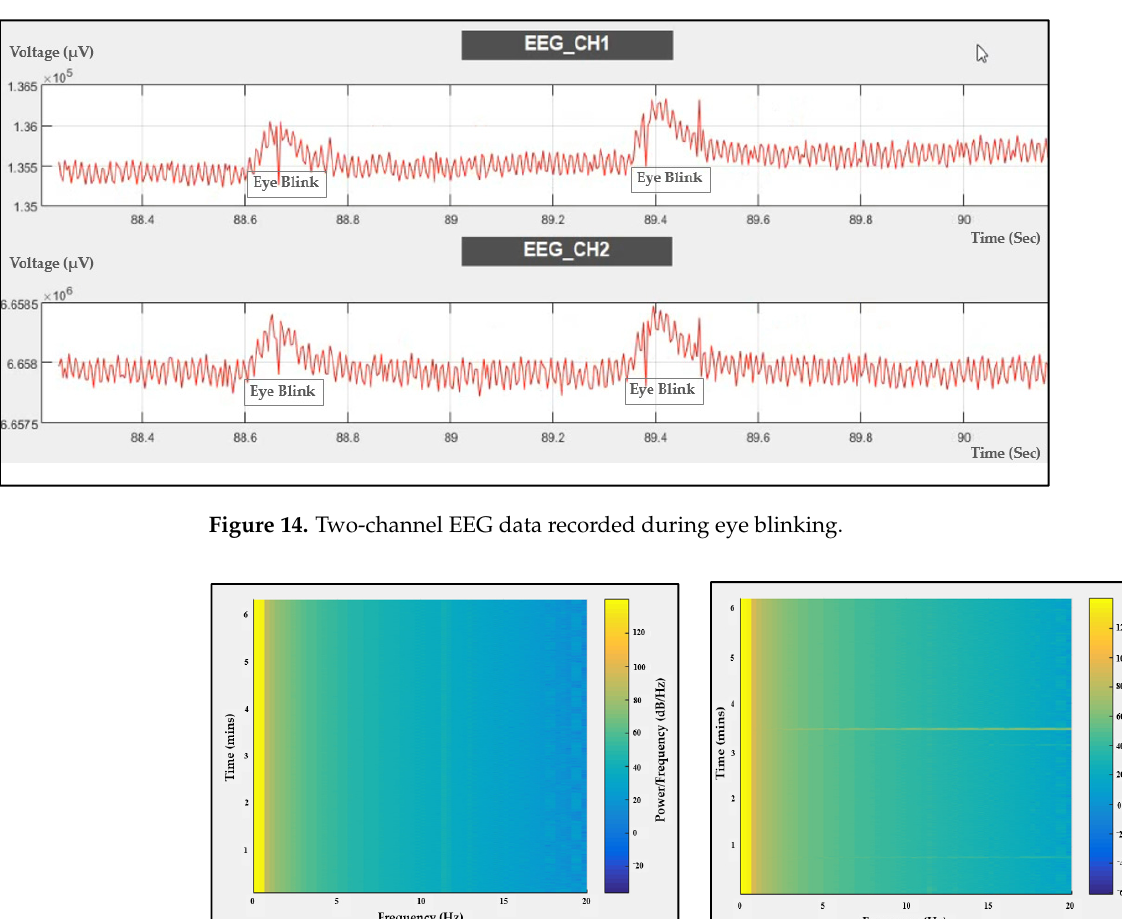
( b ) Figure 15. Alpha wave detection while (a) eyes were open and (b) eyes were closed. 4.3. FNIRS Signal Using EEG/fNIRS System 4.3.1. fNIRS Recording Using Solid Phantoms fNIRS signal was evaluated using two silicon-based tissue phantoms made from pol- ydimethylsiloxane (PDMS), curing agent, TiO2, and India ink. In the near-infrared range, PDMS has a refractive index of about 1.43 (equal to tissue refractive index). TiO2 is con- sidered as a scattering agent for setting the scattering properties of the phantom, and the India ink set the absorption properties of the phantom. The amount of India ink used in one phantom was more than that used in the other (darker phantom contains 220 g of silicon, 24.8 g of curing agent, 0.317 g of TiO2, and 270 µL of India ink) to represent a high absorbance of light (absorption coefficient is about 0.088 mm − 1 and reduced scattering coefficient is about 1 mm − 1 ), whereas the other had less India ink (brighter phantom contains 219.7 g of silicon, 24.7 g of curing agent, 0.314 g of